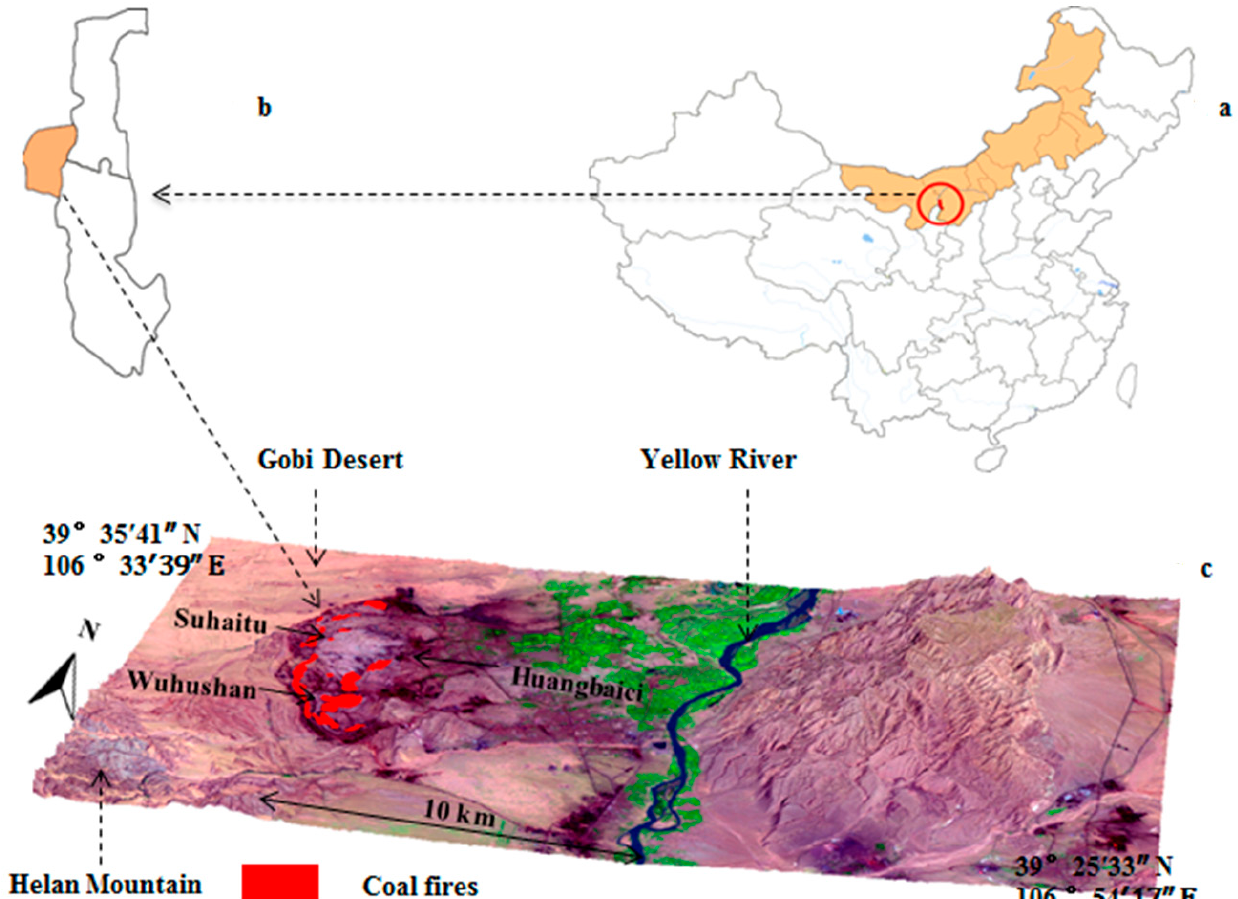
Figure 2. Study area of the Wuda Coal Field: ( a ) shows the location of the study area in Northwest China. ( b ) shows the WCF located in the Wuda district, Wuhai city; and ( c ) is a 3-D False Color Composite image (generated by coding ETM+7/4/2 in R/G/B) based